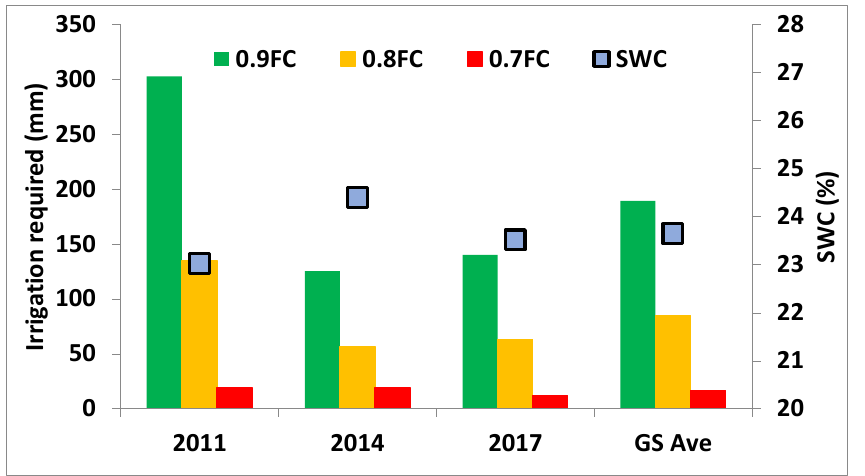
Figure 7. Potato supplemental irrigation requirement for the various irrigation scenarios for each growing season during the monitoring period (Note: 2010 growing season data [incomplete] not included).